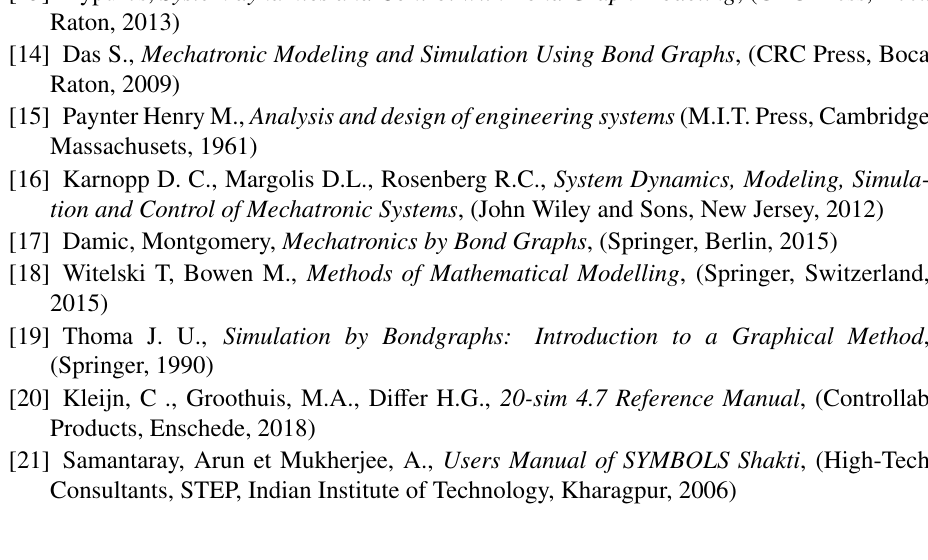
Figure 8. Block diagram of the ACV actuator with a one stage